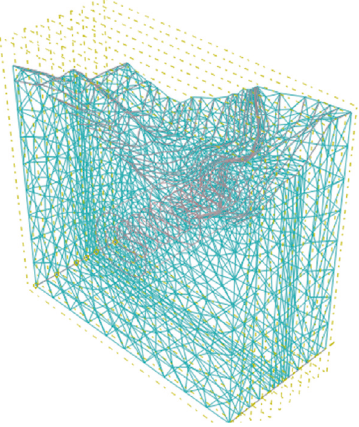
Figure 4: Outer contour of curtain grouting model.